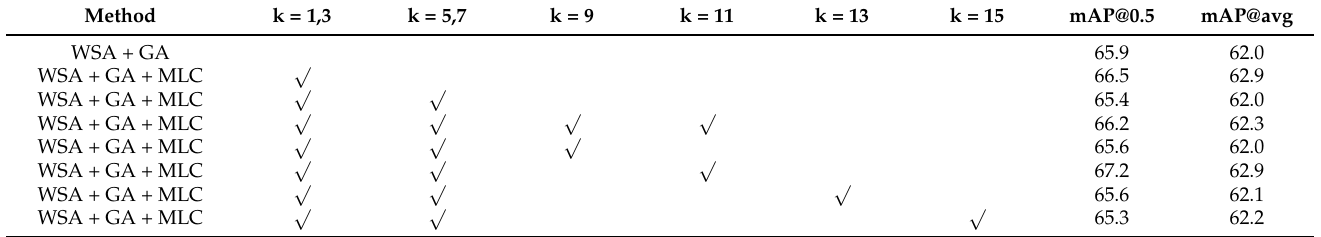
Table 5. Ablation study on the kernel size in MLC. convolution with corresponding kernel size or not,